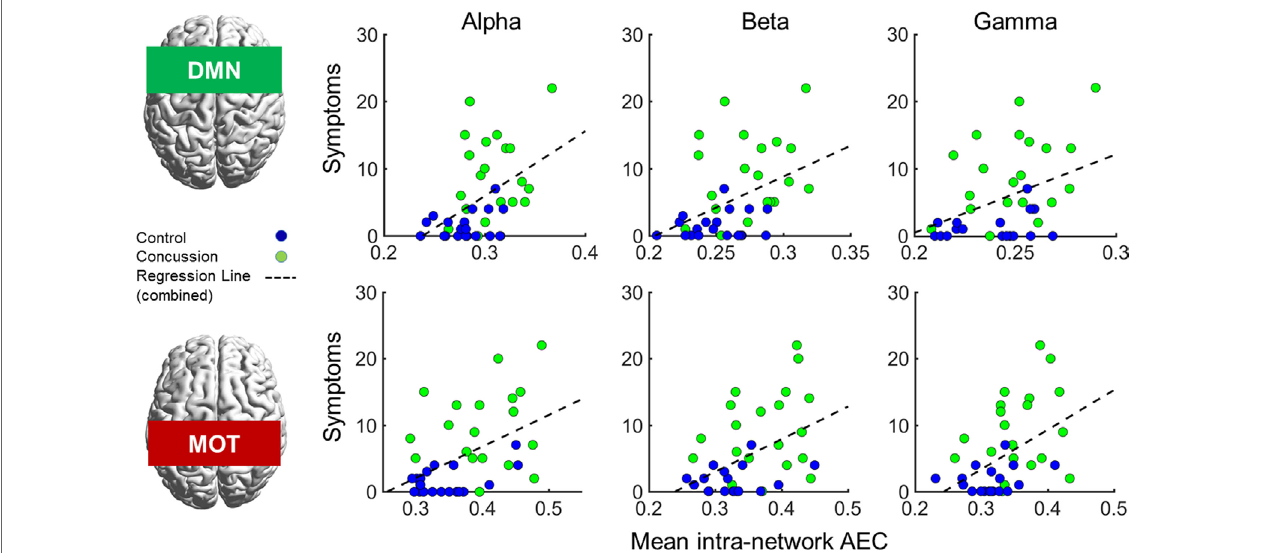
Table 2. Abbreviation: AEC, amplitude envelope correlations.